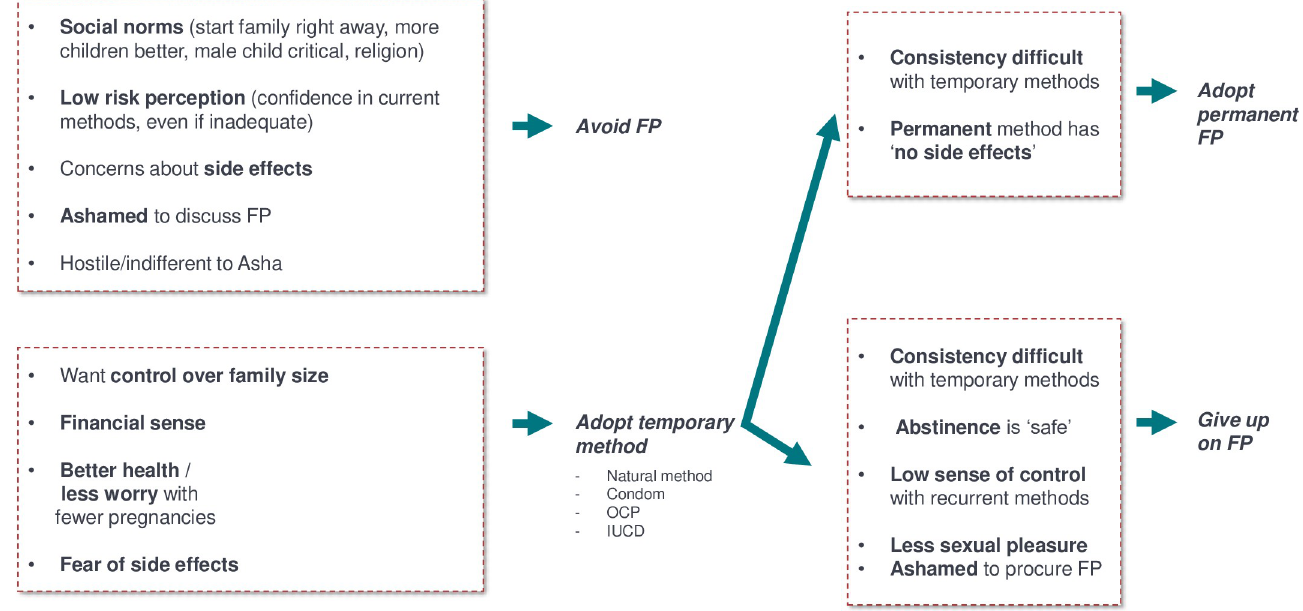
Fig 4. FP decision tree. Analysis of qualitative findings suggest three potential pathways for FP. Interaction of social norms, risk perception, beliefs about side effects, shame, and other beliefs lead families to 1. Avoid FP altogether, or 2. Adopt a temporary method and eventually a permanent one or 3. Adopt a temporary method but additionally give on FP altogether. Additional quantitative research is needed to confirm